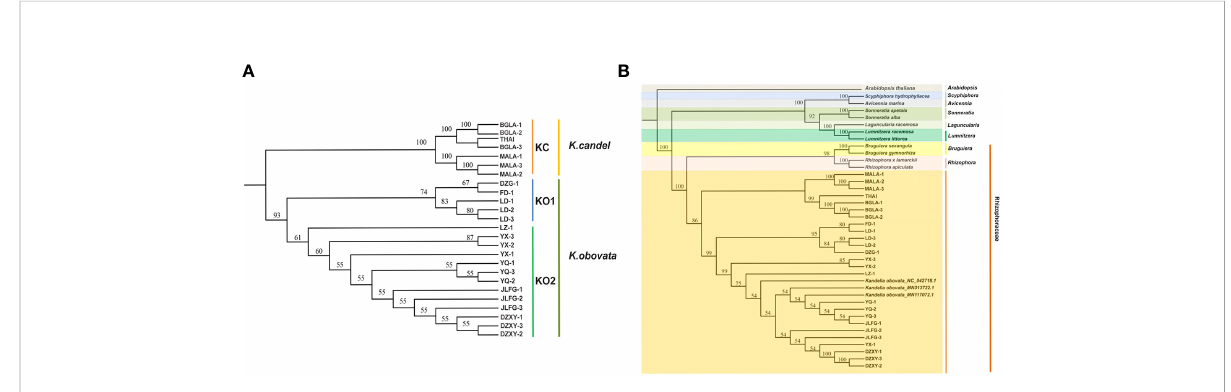
FIGURE 2 Phylogenetic tree. (A) The Kandelia tree constructed using the UPGMA model based on the 76 single-copy genes in the 25 whole cp genomes. (B) The tree constructed using the UPGMA model based on 38 homologous pair genes in 13 mangrove species including 40